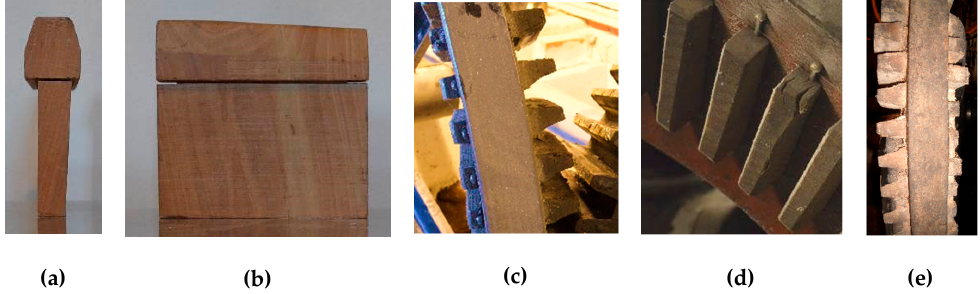
Figure 15. The mortise gear (Riviera): (a) Side view; (b) frontal view; (c) worn teeth; (d) particular of the wooden teeth mounting on the wheel ring; (e) wear and teeth mounting (Forno mill).